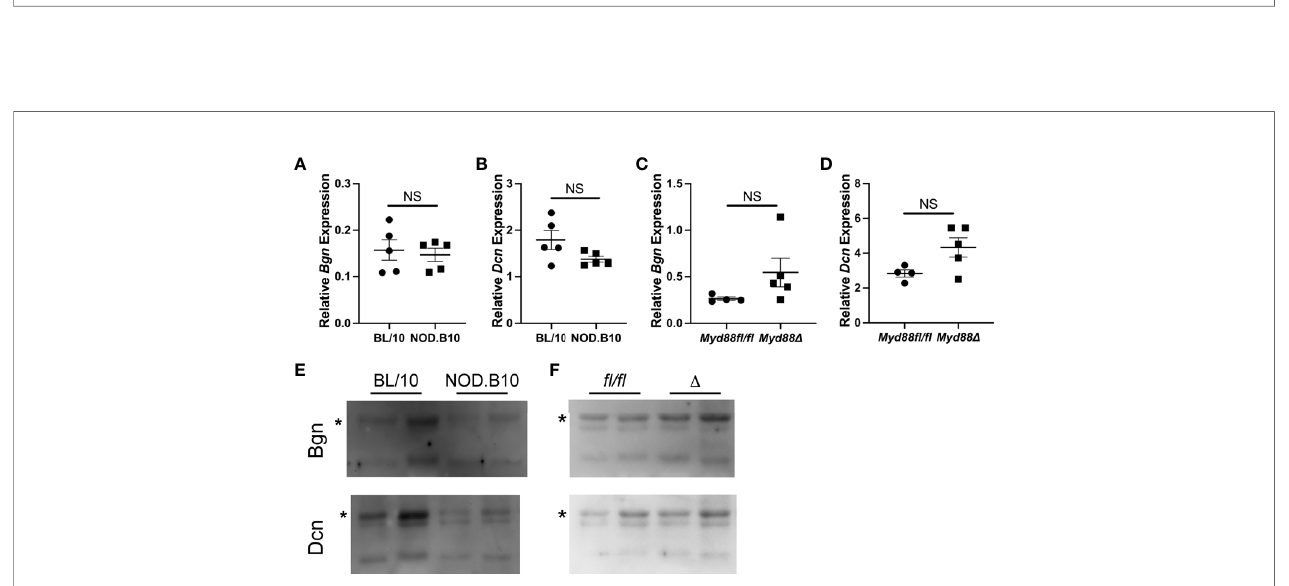
FIGURE 2 | Dcn and Bgn are detected in SMG tissue and saliva. Expression of Bgn and Dcn was determined by qPCR in SMG tissue from (A, B) BL/10 and NOD.B10 mice (n = 5 each) and from (C, D) NOD.B10 Myd88 fl / fl and NOD.B10 Myd88 D mice (n = 4 and 5, respectively) by qPCR. Expression was normalized to b -Actin. Horizontal lines represent the mean and SEM, (NS, non-signi fi cant). Expression of Dcn and Bgn in saliva was quanti fi ed in (E) BL/10 and NOD.B10 mice (n = 8 and 7, respectively) and (F) NOD.B10 Myd88 fl / fl and NOD.B10 Myd88 D females (n = 4 and 5, respectively) by western blotting. Two representative animals from each strain are shown. Full-length Bgn and Dcn are indicated by asterisks. fl / fl = NOD.B10 Myd88 fl / fl and D = NOD.B10 Myd88 D .